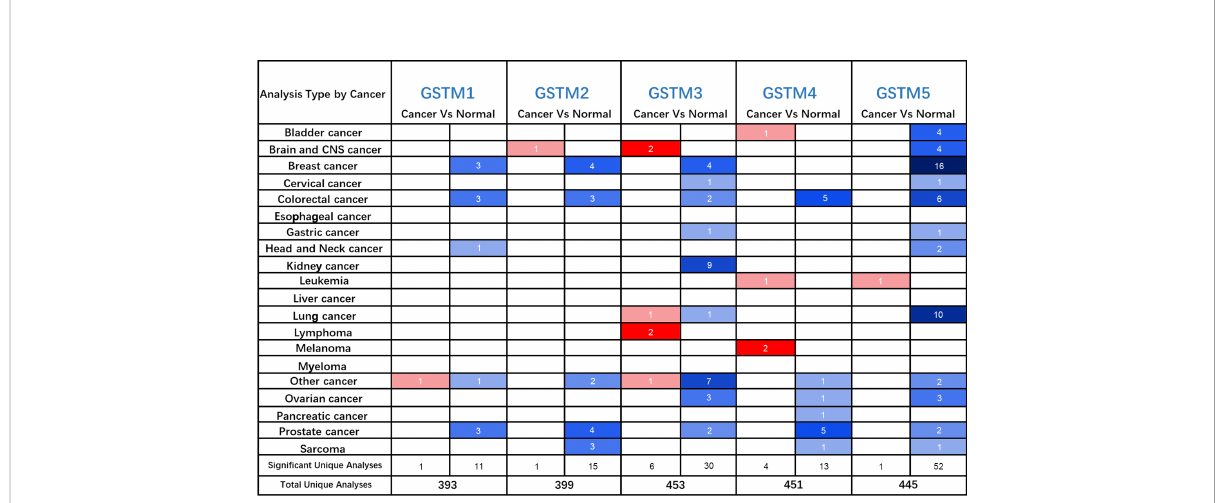
FIGURE 2 The GSTMs mRNA level in multiple cancer types. The red color cell indicates that GSTMs is enhanced in tumor samples compared to correspond normal samples, whereas blue color cell presents GSTMs is reduced in tumor samples compared to correspond normal